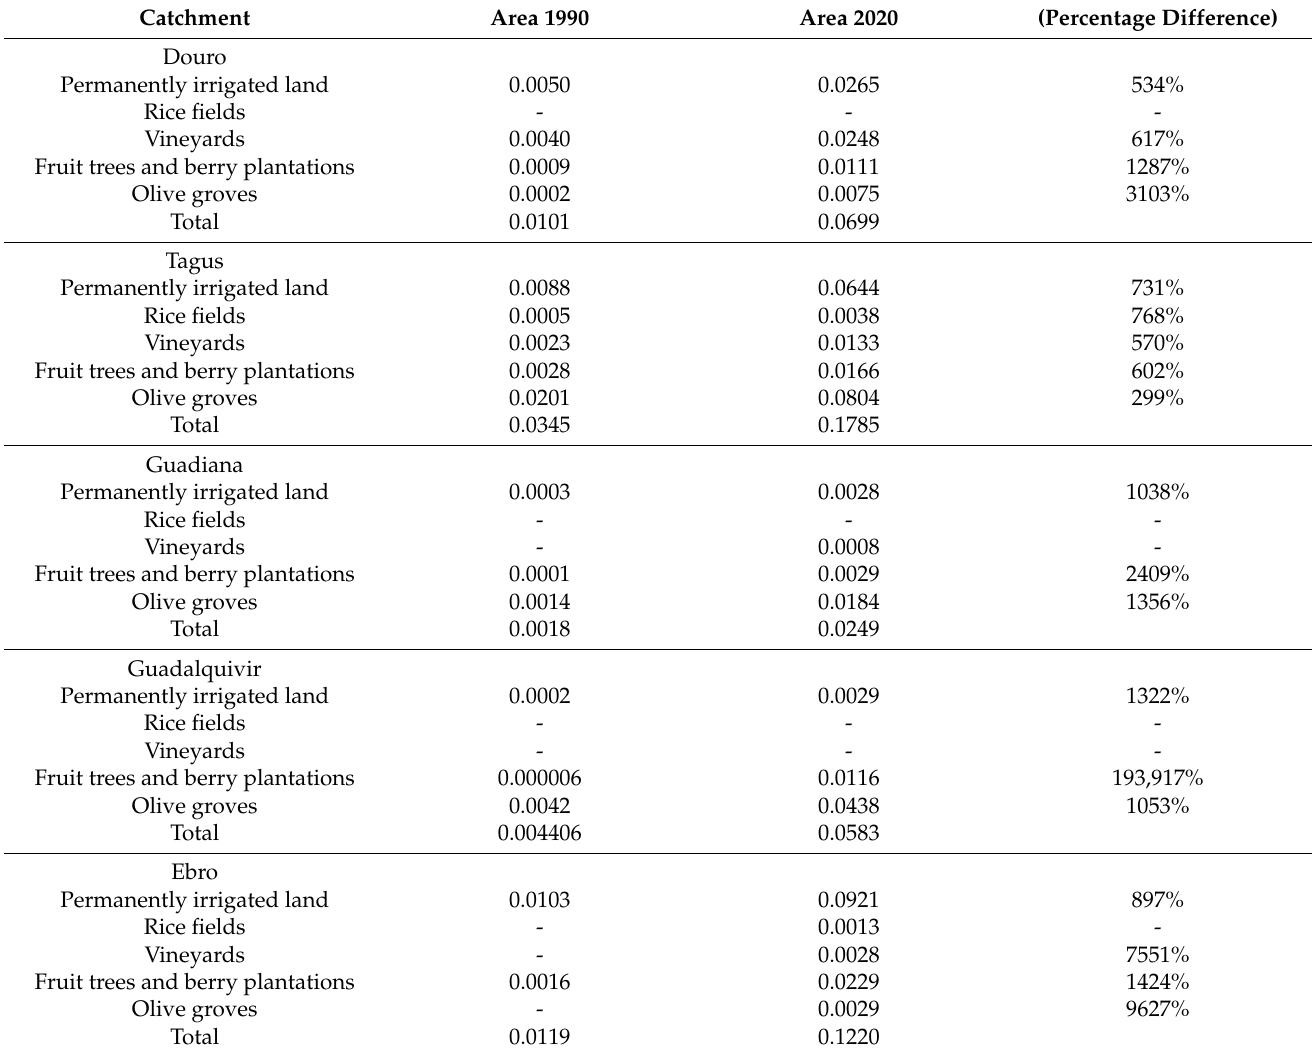
Table 2. Percentage of area change per river catchment between 1990 and 2020 for NDVI values above 0.51.